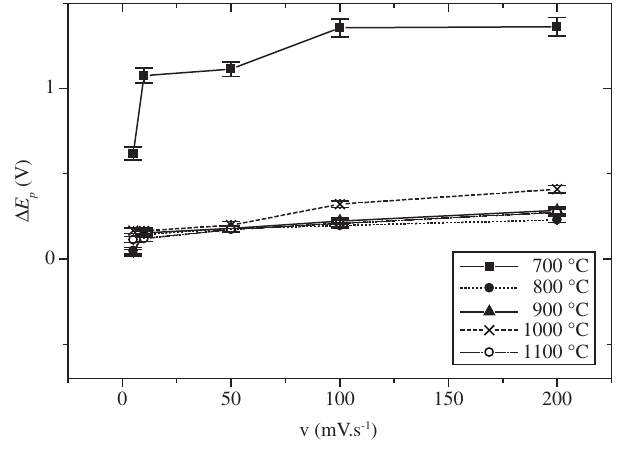
Figure 7. ∆ E as a function of sweep rate in 1 mM Ferrocyanide/0.1 M KCl p for RVC electrodes manufactured at different HTT (from 700 °C up to 1100 °C).